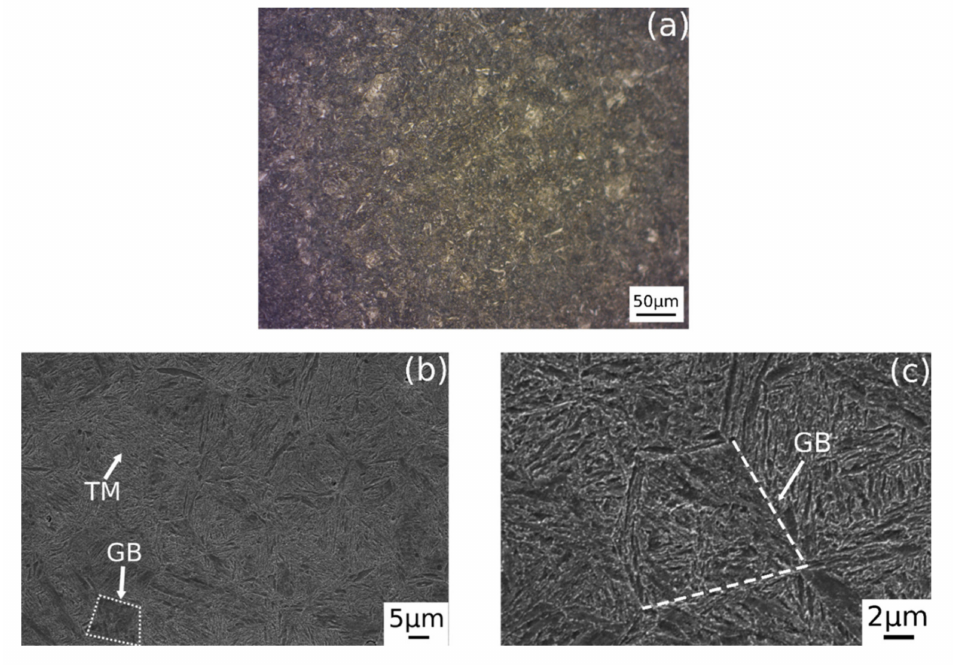
Figure 7. Microstructure of material after tempering at 600 ◦ C and air cooled. ( a ) Optical micrograph, ( b ) and ( c ) SEM